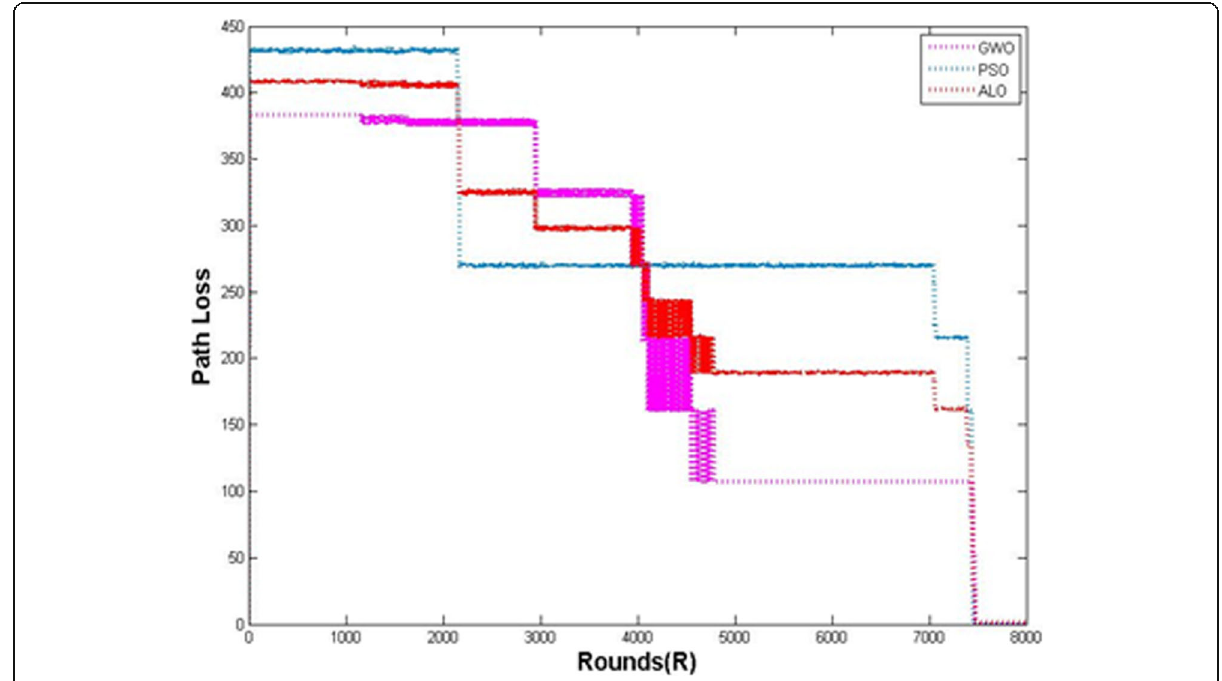
Fig. 6 Path loss for PSO, ALO, and GWO for WBAN